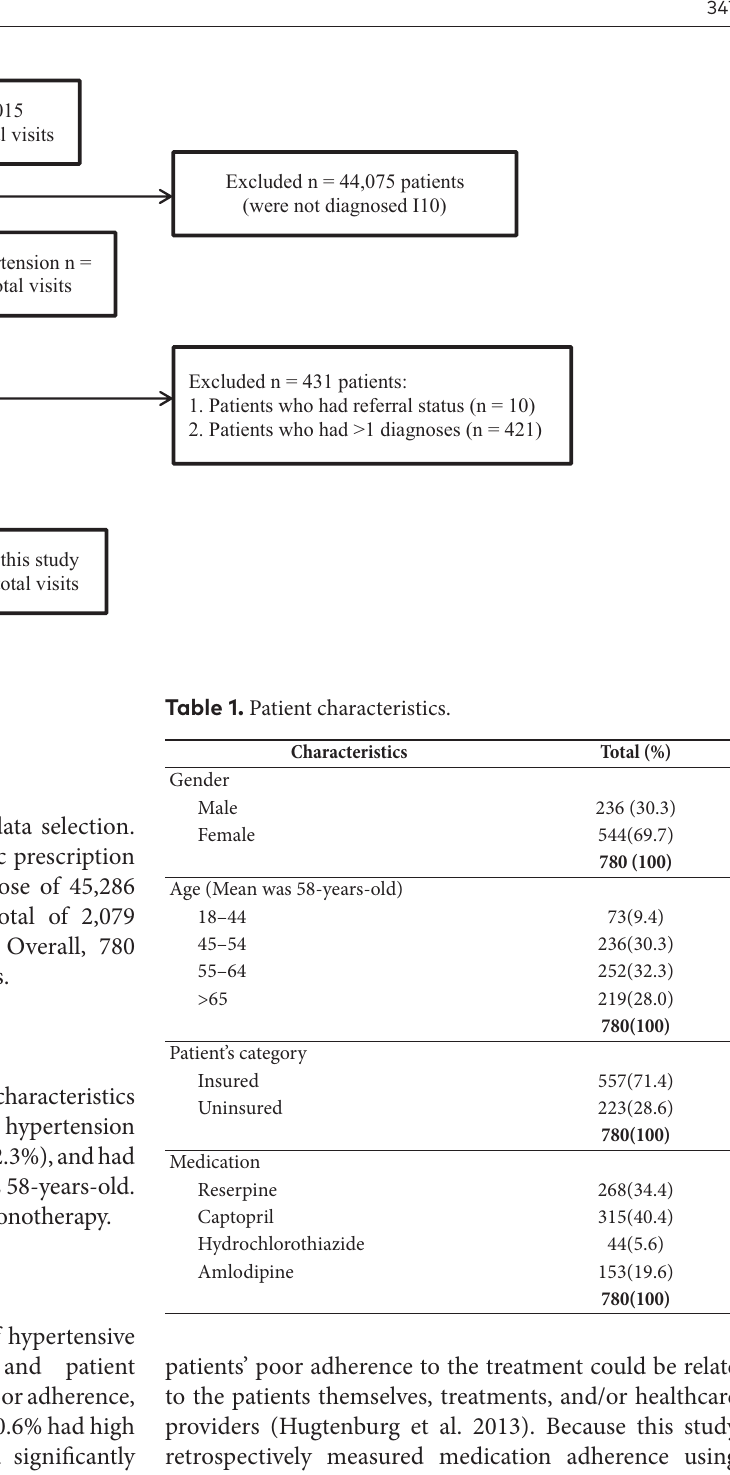
Excluded n = 44,075 patients (were not diagnosed I10)